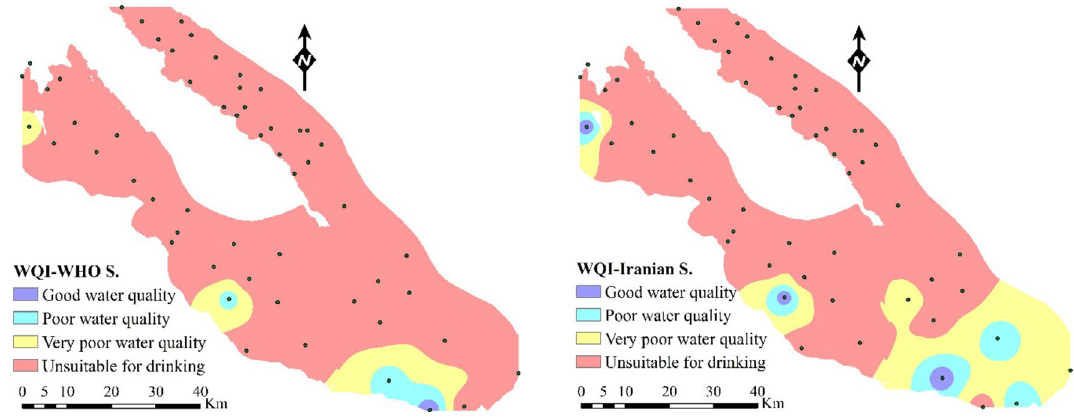
Fig. 9 Spatial distribution of water quality index (WQI) for two standards (WHO and ISIRI1053) in the study